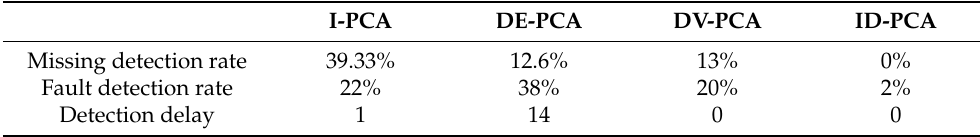
Table 4. The performance comparison for the rolling bearing outer ring. I-PCA Missing detection